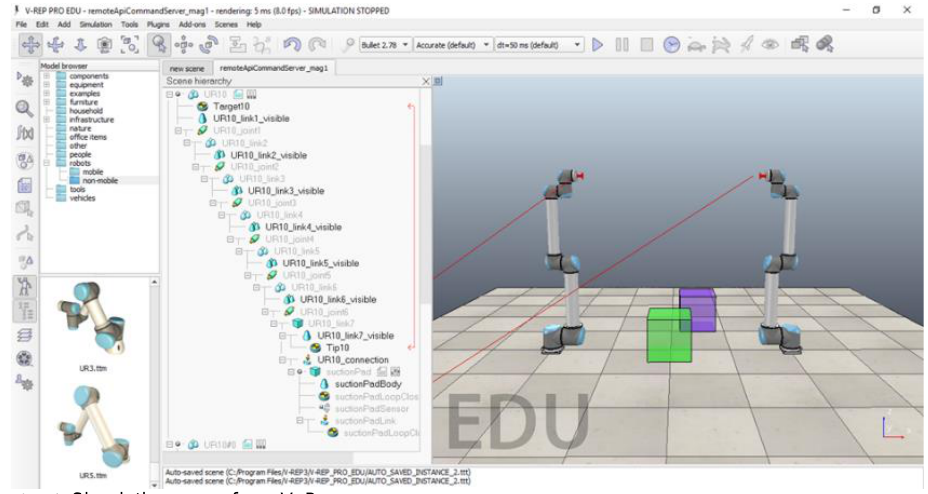
Fig. 4. Simulation scene form